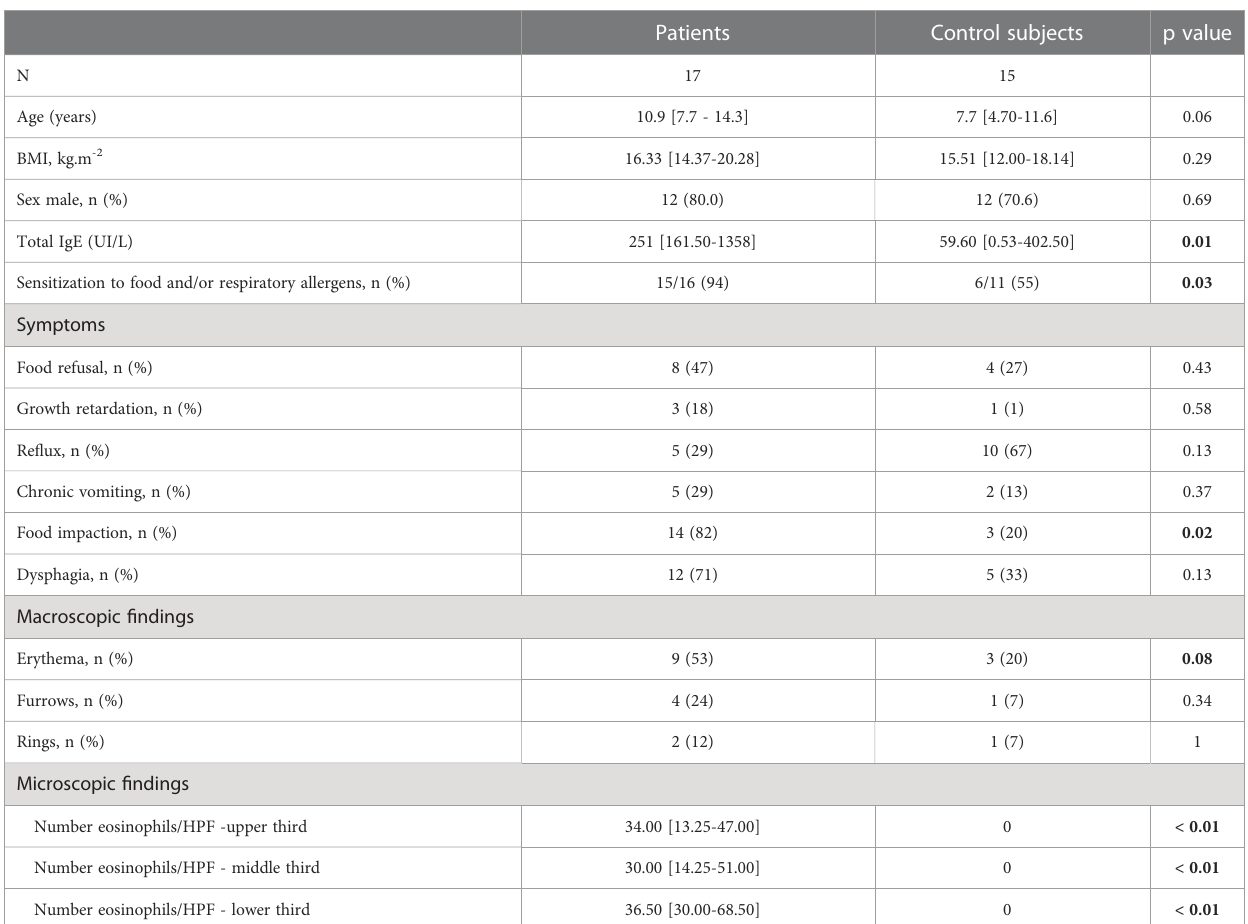
TABLE 1 General characteristics of the